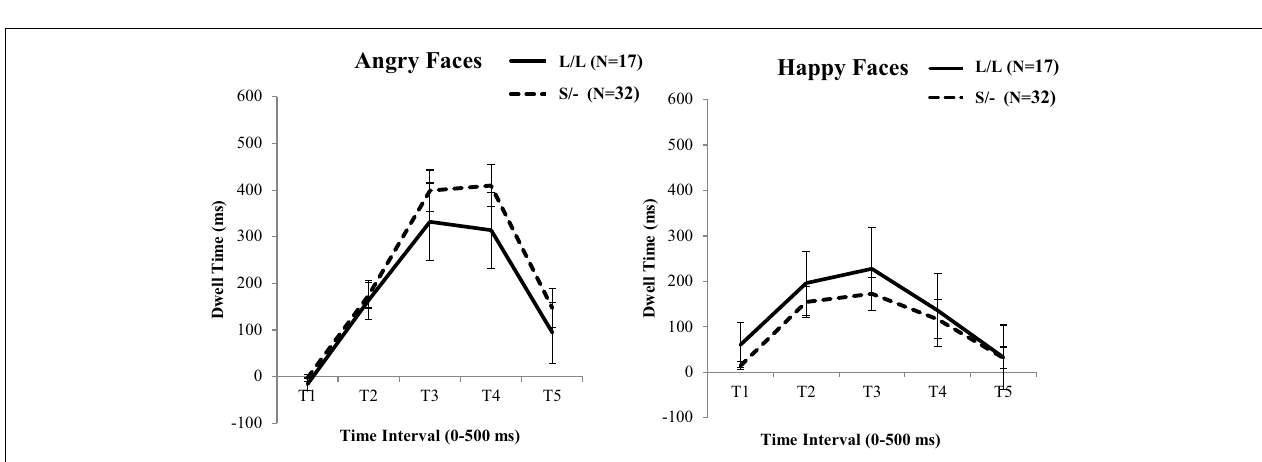
FIGURE 3 | 5-HTTLPR genotype differences in fixation duration to facial expressions of Anger versus Neutral (left) and Happiness versus Neutral (right) . Genotype groups do not differ at any time point across the two types of emotional faces. Error bars denotes 1 SEM.